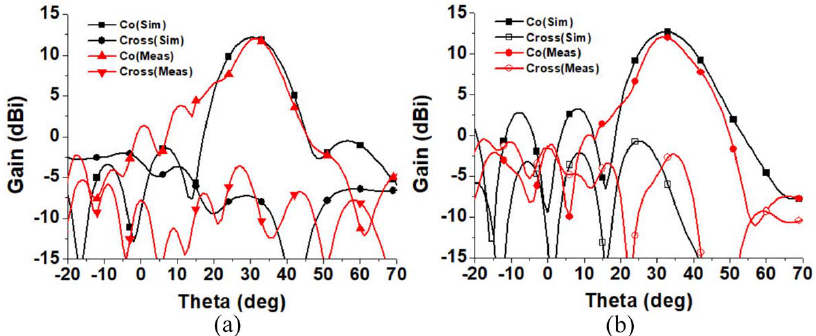
Figure 21. ( a ) The measured and simulated co–pol and cross–pol gains of the proposed antenna in the E–plane when excited at Port 3 and LP is generated; ( b ) the measured and simulated co–pol and cross–pol gains of the proposed antenna in the E–plane when excited at Port 4 and LP is generated. Table 3. The comparison between the proposed design and previous antennas.